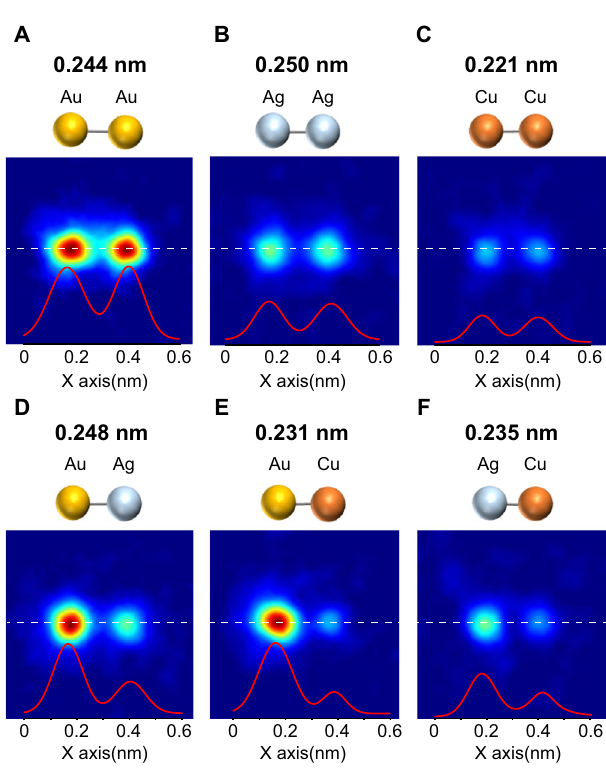
Fig. 4 ADF-STEM averaged images of homometallic and heterometallic dimers. A – F Most stable structure by DFT calculation (upper part) and the corresponding average STEM image at the calculated equilibrium interatomic distance (lower part). The average images are composed of multiple snapshots during the movie recording. Each image ( A – F ) corresponds to Au – Au, Ag – Ag, Cu – Cu, Au – Ag, Au – Cu, and Ag – Cu, respectively. Each red line in the image represents the cross section of the ADF intensity on the line passing through the center of both